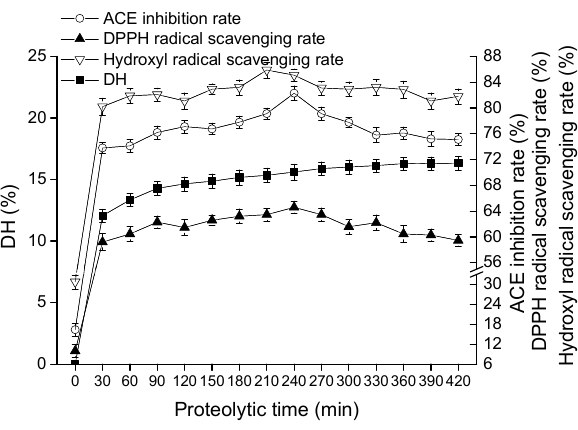
Figure 1. Effect of proteolytic time on DH, ACE inhibitory activity, and antioxidant activity of hydrolysate at pH of 8, temperature of 40 °C and E / S of 10% ( w / w ). The error bars represent standard deviation of means ( n = 3).